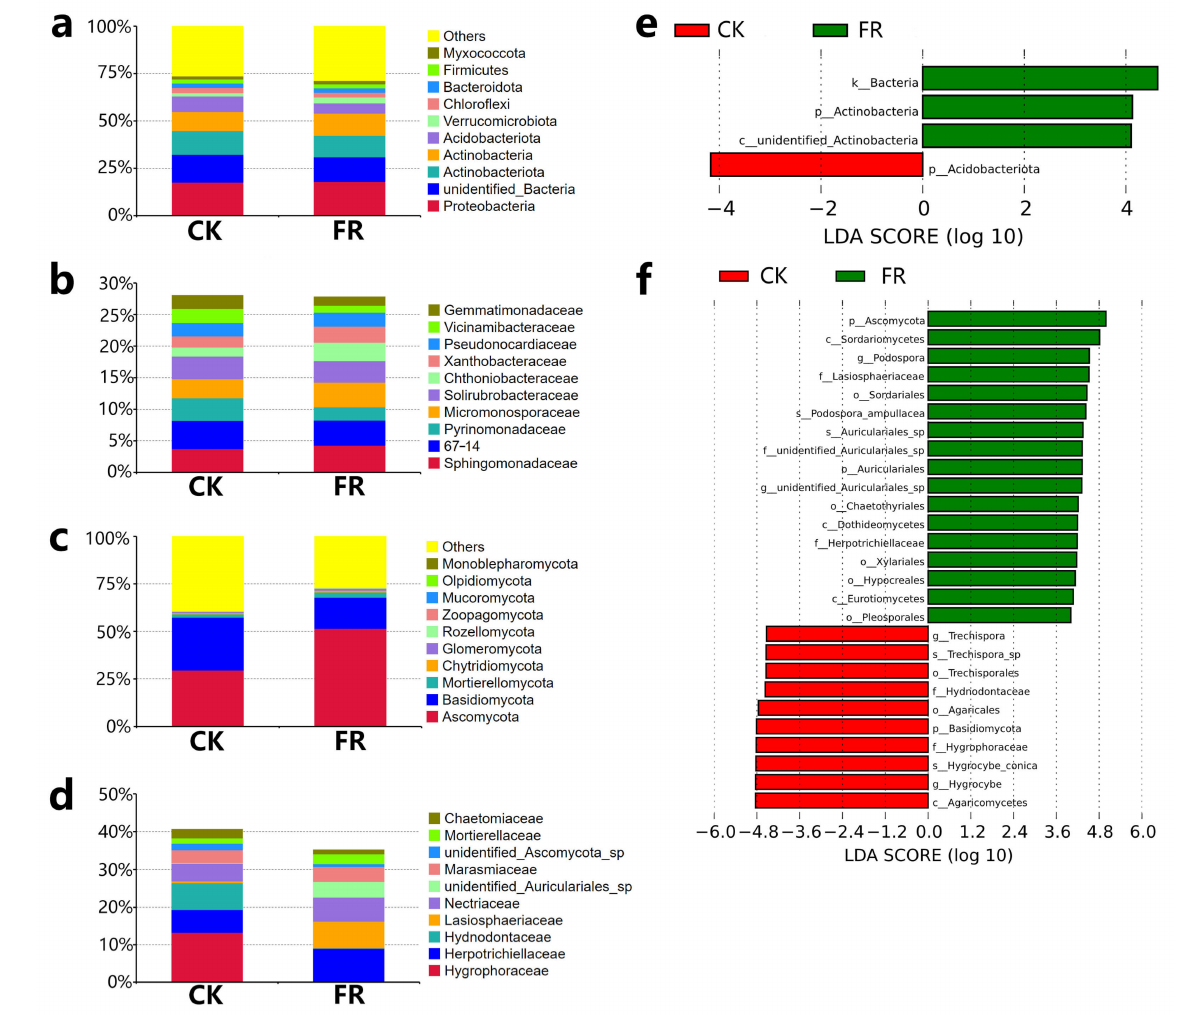
Figure 5. Microbial community composition and LEfSe analysis of bacteria and fungi in the FR and CK zones of the fairy ring ecosystem. The relative abundance of the bacteria community at the ( a ) phylum level and ( b ) family level. The relative abundance of the fungal community at the ( c ) phylum level and ( d ) family level. LEfSe analysis of ( e ) bacteria and ( f )